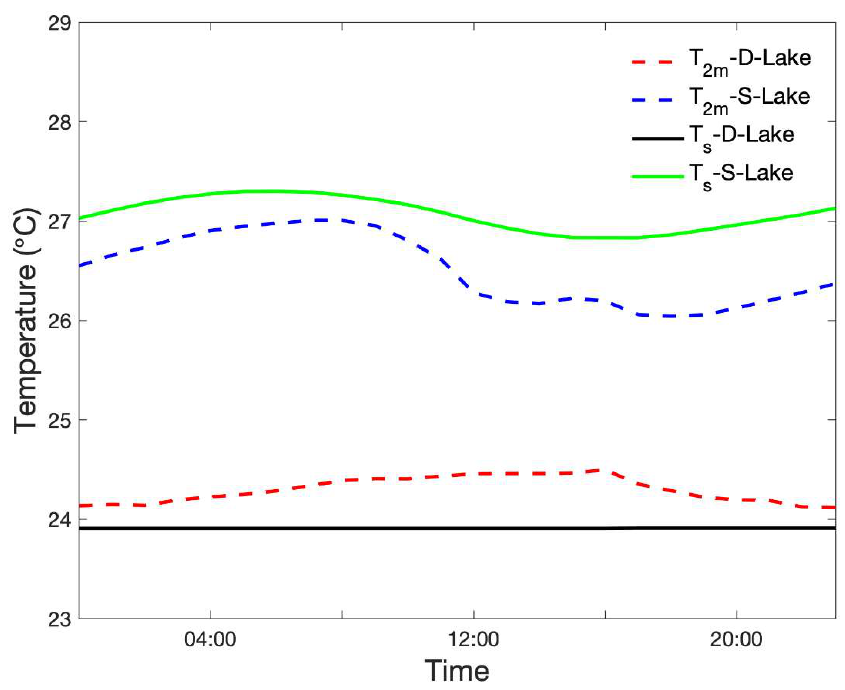
Figure 4. The average lake surface temperature and the 2 m air temperature on the lake over 17 lake breeze days. The solid green line and solid black line were surface temperatures for S-Lake and D-Lake, and the blue and red dotted lines were 2 m air temperatures for S-Lake and D-Lake, respectively.